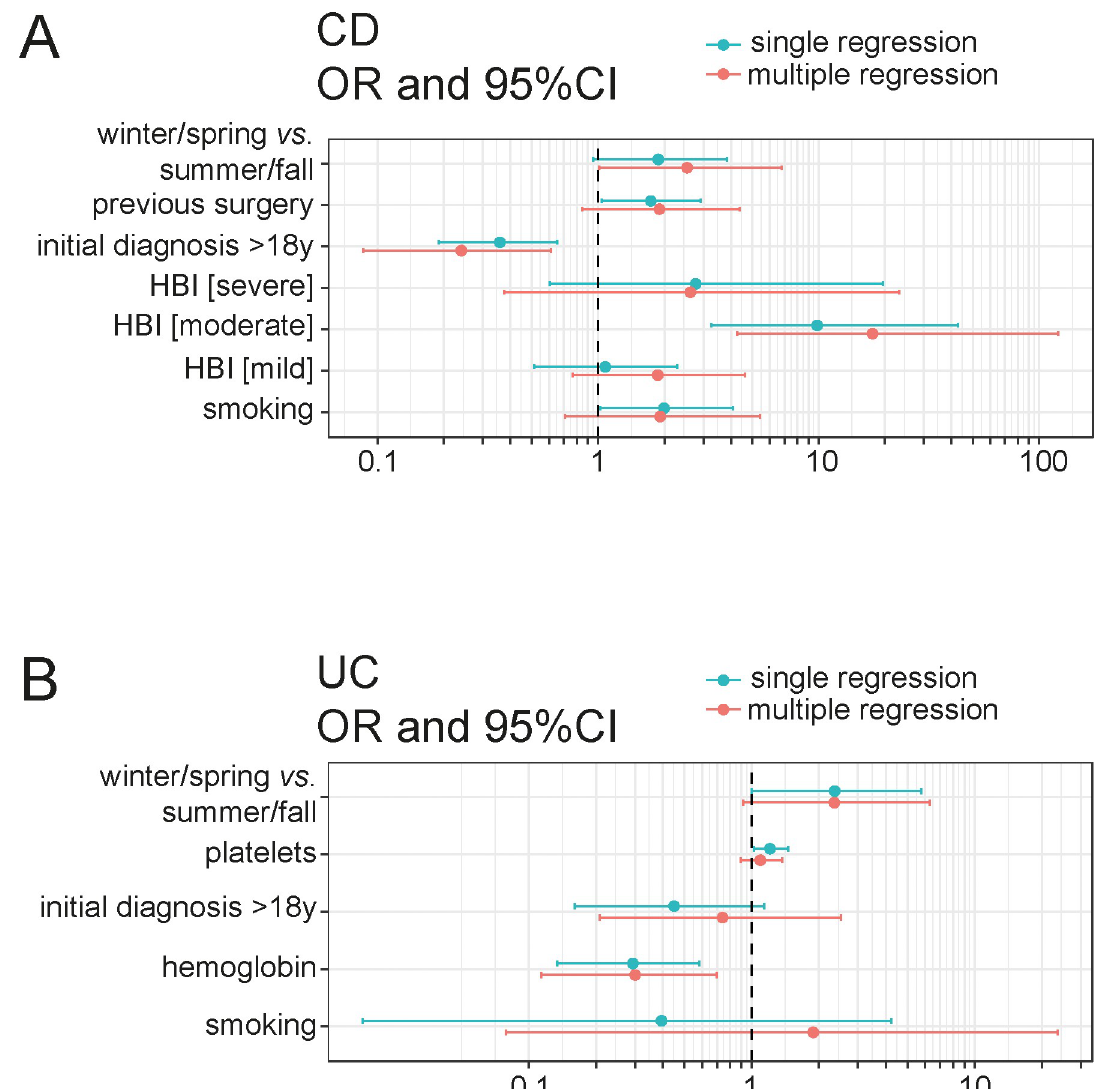
Fig 3. Univariable and multiple regression analyses to determine independent risk factors for vitamin D deficiency in patients with CD (A) and UC (B) . Models of multiple regression including the indicated clinical factors were used and are indicated as Forest